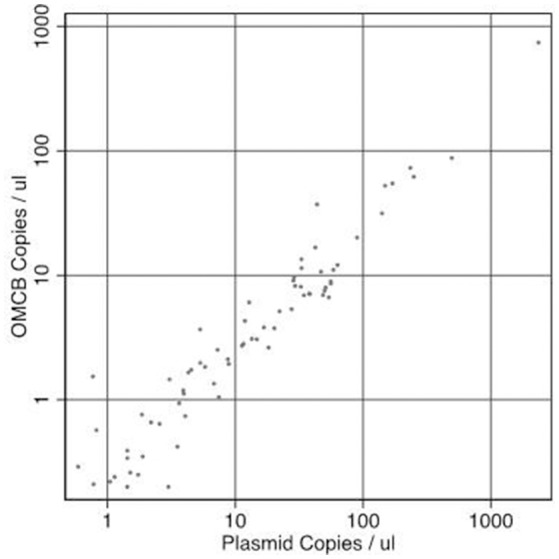
The relationship between paired measures of copies of Chlamydia trachomatis plasmid/μl vs. omcB/μl in the same sample. Correlation R-squared = 0.989.